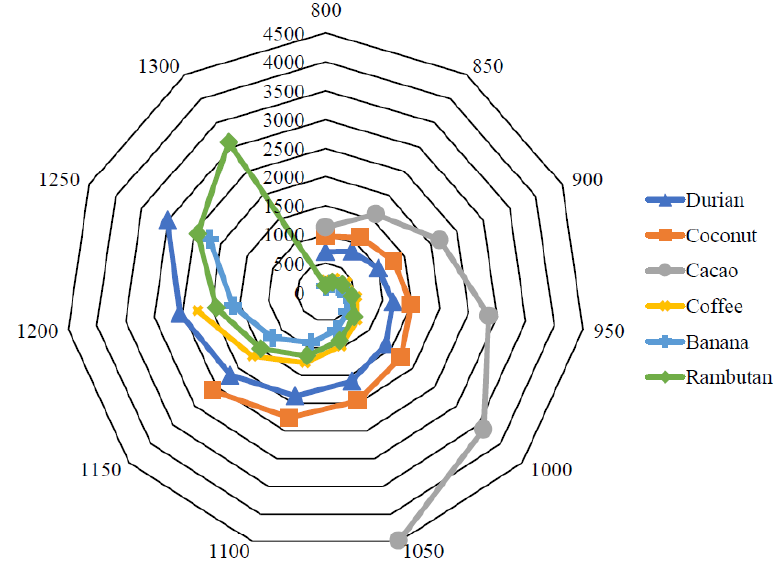
Figure 5. Progress of deformation energy E d (J) increasing in relation to specific bio-briquette bulk density ρ (kg∙m −3 ).